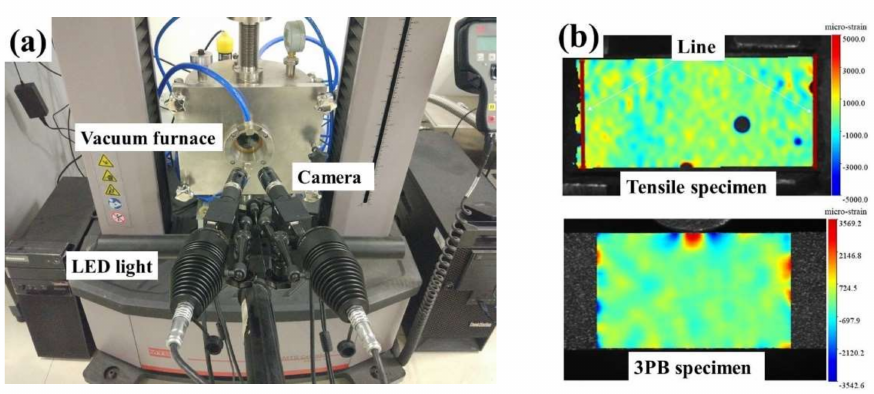
Figure 2. ( a ) Experimental setup of the 3D—DIC system; Strain field in form of contour plot. ( b ) tensile specimen and 3PB